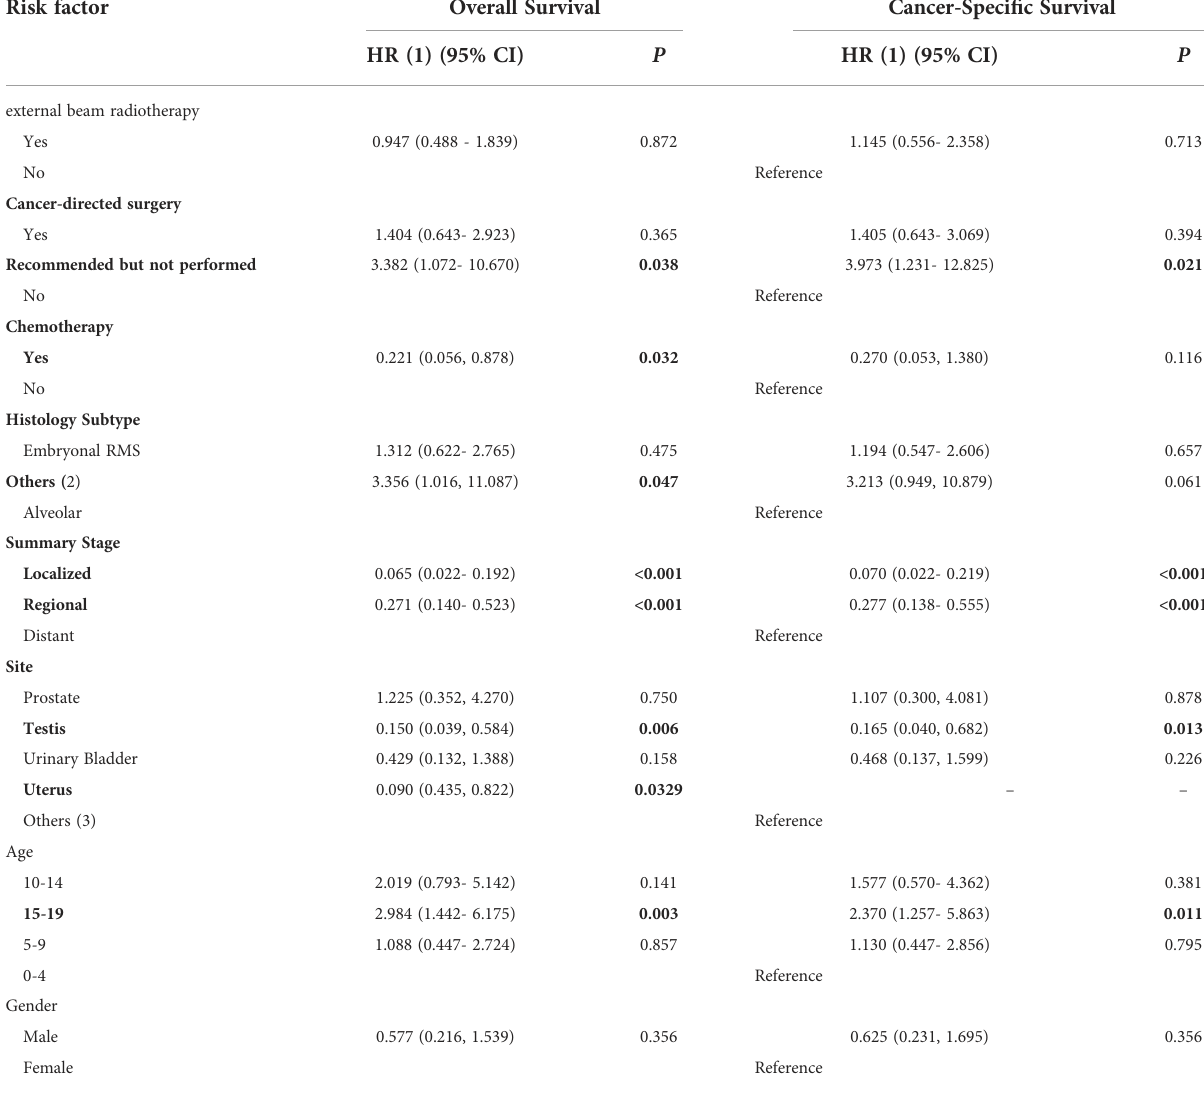
TABLE 2 Multivariable Cox regression analysis of predictors of OS and CSS for pelvic and genitourinary